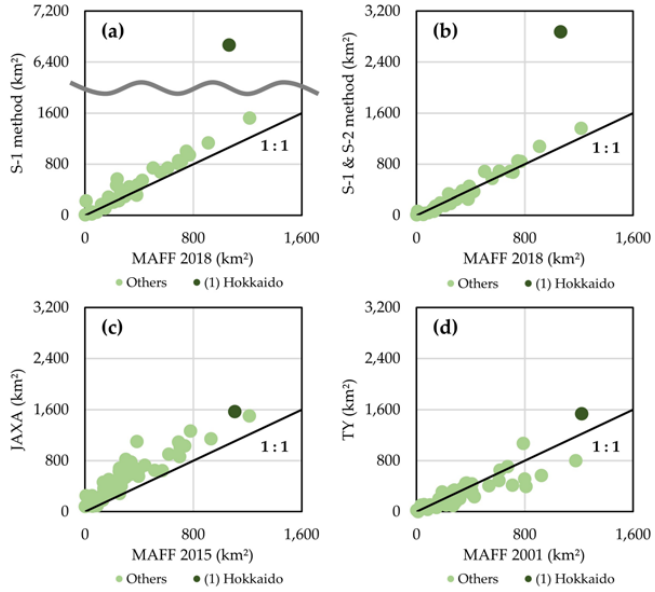
Figure 9. Comparisons of paddy field areas in each prefecture calculated from each paddy field map with paddy field areas published by MAFF: ( a ) S-1 method and ( b ) S-1 & S-2 method versus 2018 MAFF data for both food rice and feed rice. ( c ) JAXA versus 2015 MAFF data for both food rice and feed rice. ( d ) TY versus 2001 MAFF data for food rice.